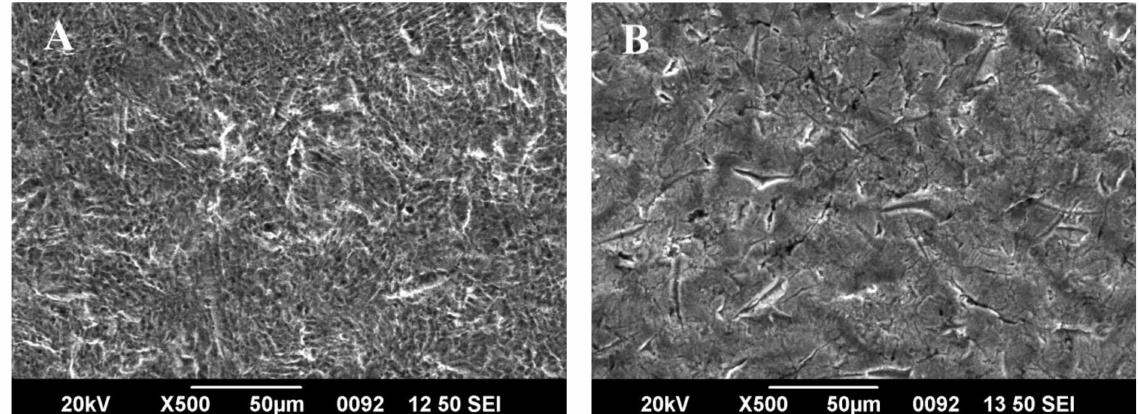
Figure 9. SEM images of coated SS 420A ( A ) before sterilization ( B ) after 100 cycles of